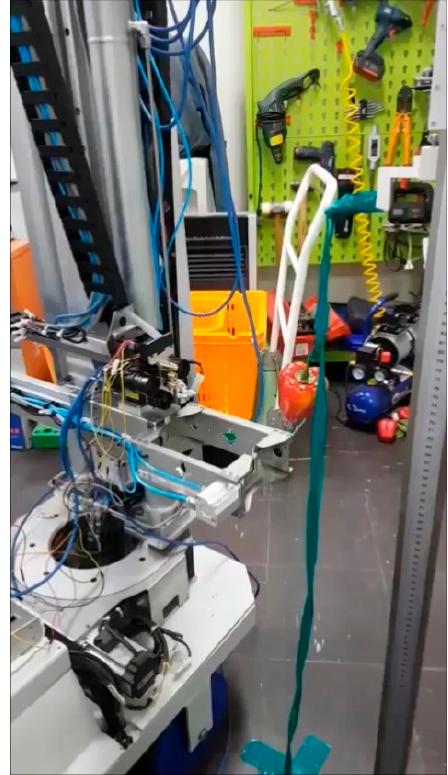
Figure 13. Set-up of control variables.